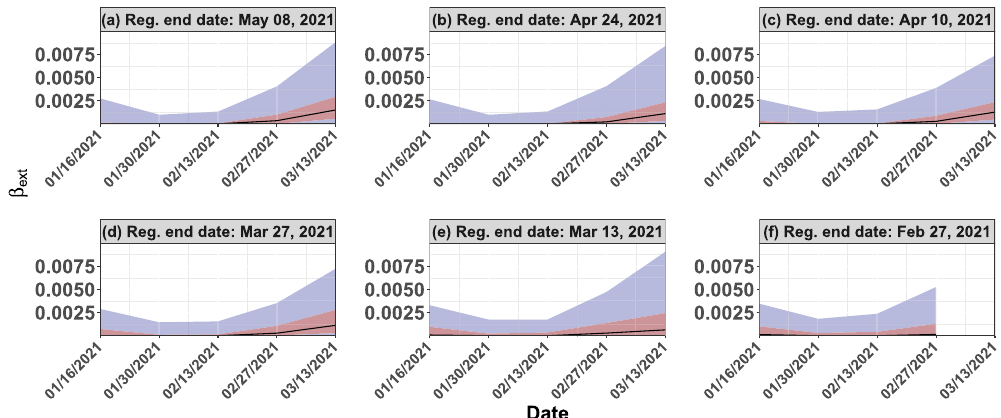
Figure 8. Plots ( a )–( f ) capture the quantiles of β e xt ’s across Indian districts over two-week time windows from 01/16/2021 to 03/13/2021. Regression of Plots ( a )–( f ) uses data until 05/08/2021, 04/24/2021, 04/10/2021, 03/27/2021, 03/13/2021, and 02/27/2021,